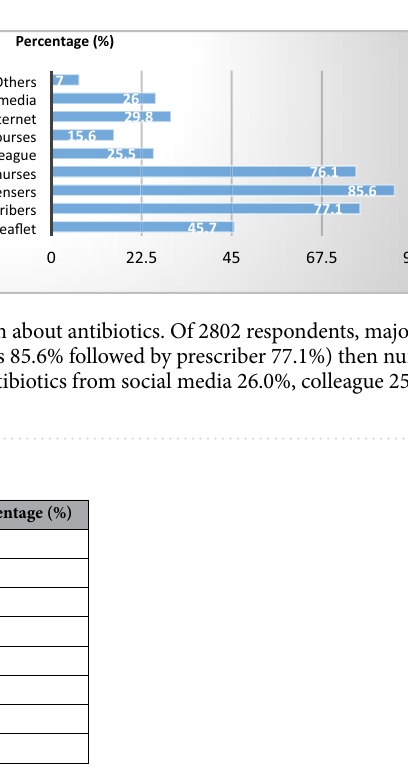
Table 3. Overall parents’ KAP on rational use of antibiotics in